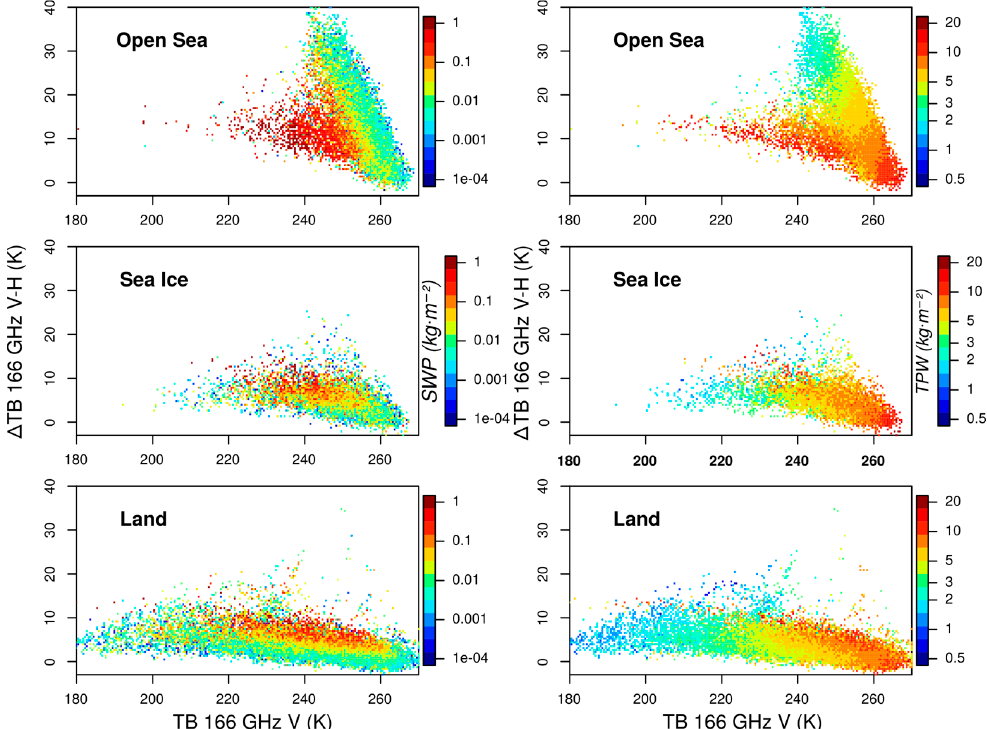
Figure 7. Scatterplots of the ∆ TB-TB for snowfall pixels in the three surface type manifolds: open sea (SIC < 57%) ( top ); sea ice (SIC > 57%) ( middle ); and land ( bottom ). ∆ TB-TB space is divided into 200 × 100 bins, and the mean SWP ( left ); and TPW ( right ) values in each ∆ TB and TB bin are represented (in log scale).